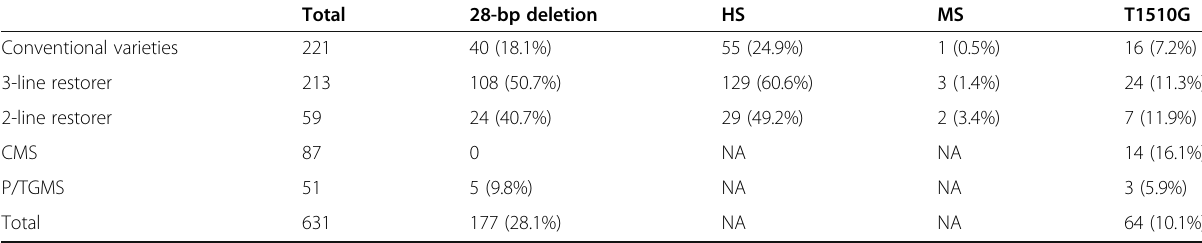
Table 1 Indica accession numbers of the 28-bp deletion, T1510G mutation, and lines susceptible to BBC Total 28-bp